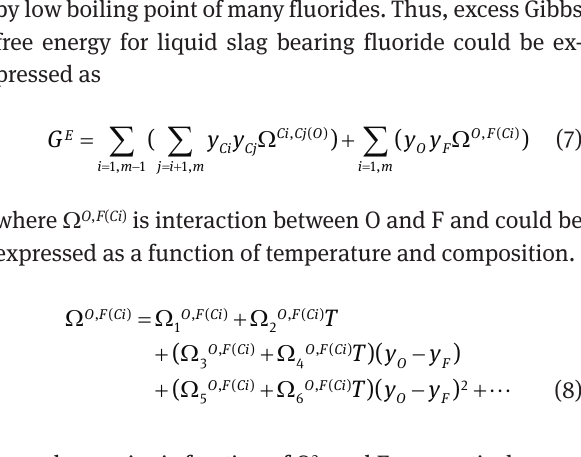
Fig. 1: Comparision between calculated and experimental activity of CaO (with solid CaO as standard state) at 1723 K in CaO-CaF 2